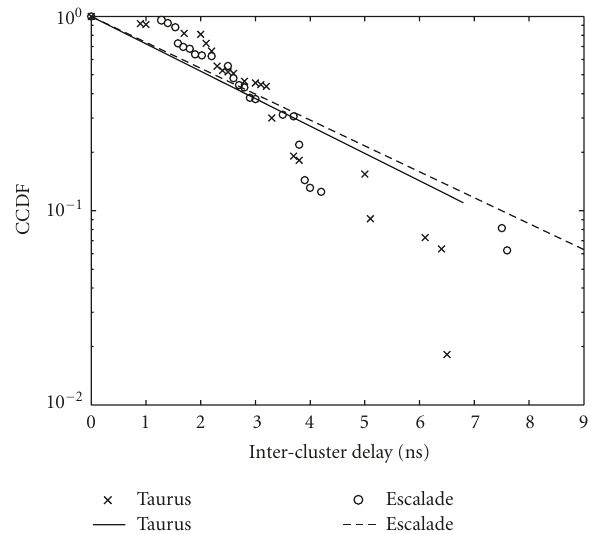
Figure 13: CCDF of intercluster arrival intervals and the best- fit exponential distributions for measurements inside the engine